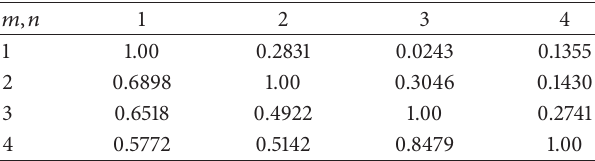
Table 3: Correlation matrix for UOC (lower/upper triangular part: amplitude/phase).